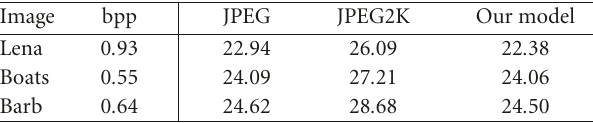
Table 2: Compression results in terms of PSNR for Lena, Boats, and